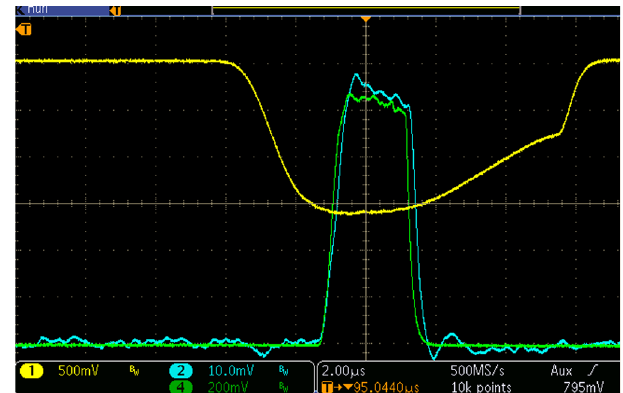
FIG. 15. LiF crystal positioned after the current monitor ACCT2 with the polished faces parallel to the beam propagation direction just after proton irradiation. The green coloration, observed by the naked eye, is due to the broad absorption bands of proton-induced aggregate color centers.